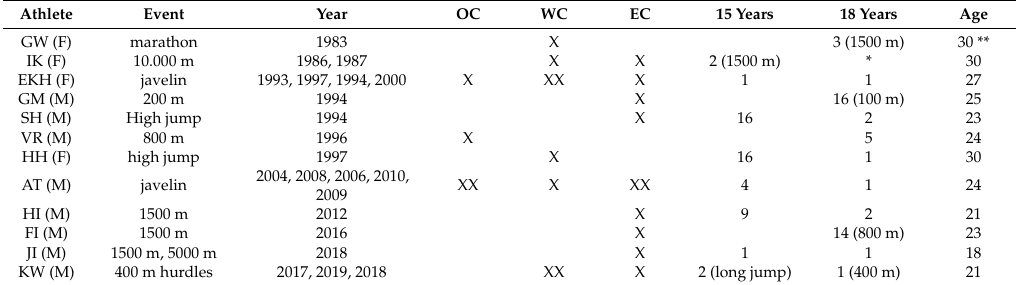
Table 3. Norwegian athletes who have become OC, WC and / or EC from 1980 to 2019, their best ranking in any event at ages 15 and 18 years, and the age at which they won their first international title in track and field events or marathon. If their best ranking at ages 15 and 18 years is in another event than the one they have won an international title in, the event is noted in parentheses. M = male, F =